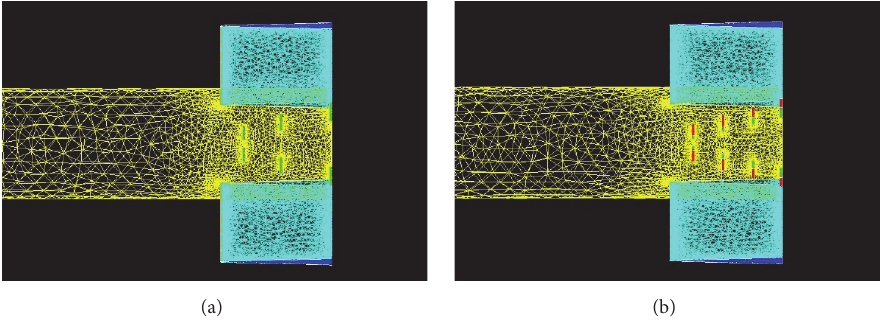
Figure 8: Computational grids for the new microflap cases: (a) 6 and (b) 8 flaps.